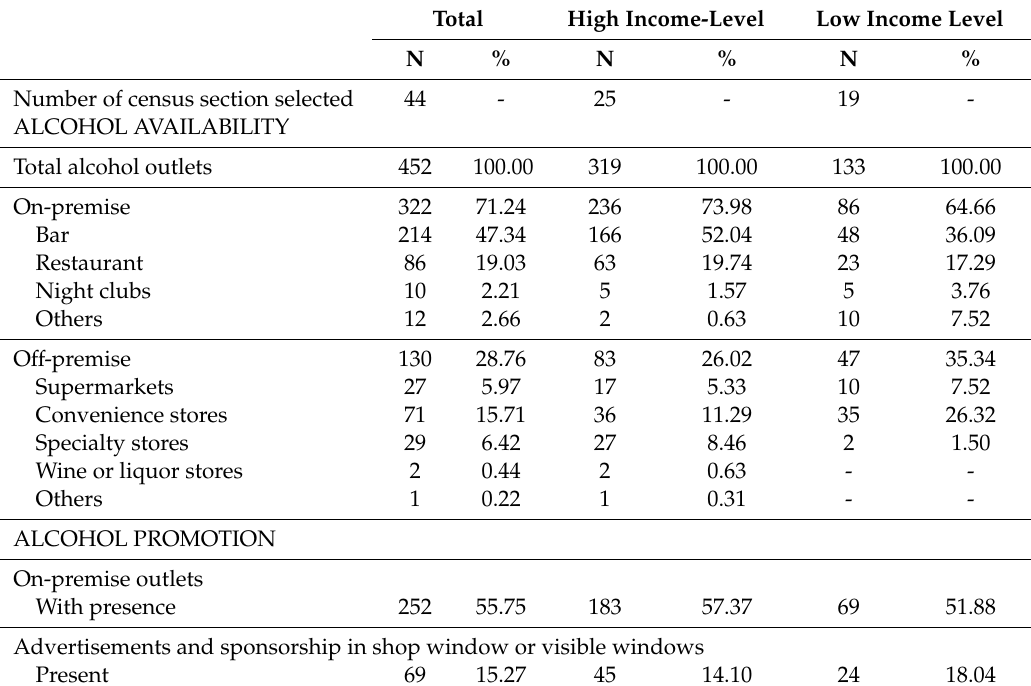
Table 1. Distribution of alcohol features associated to alcohol outlets objectively measured within